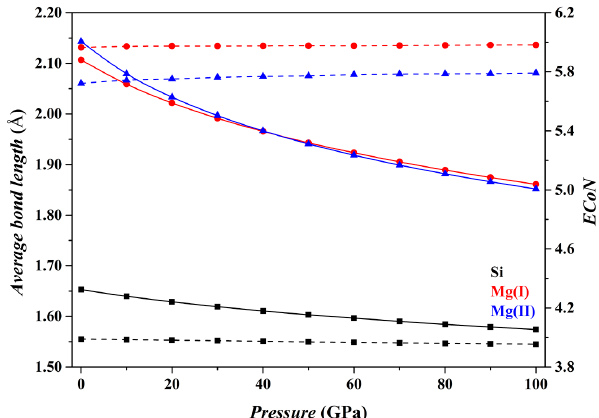
Figure 2. Evolution of the average bond length ( d mean ) and ECoN parameters of the polyhedra of the Fo phase as pressure increases from 0 to 100 GPa (0 K). For the information about the Mg(I) and Mg(II), see Supplementary Table S1.